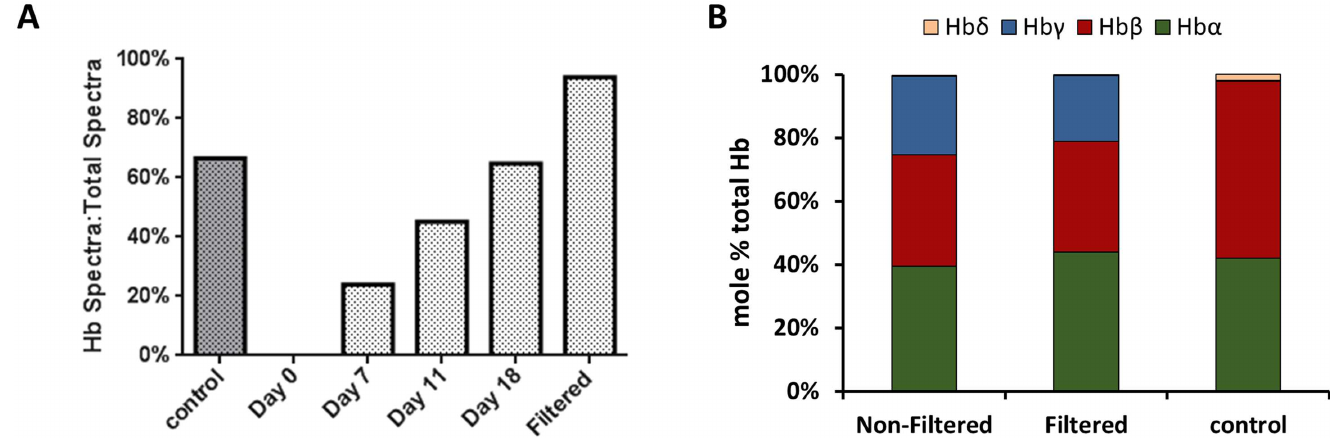
Fig 2. Proteomic analysis of hemoglobin expression. (A) Ratio of spectra (%) matched specificallyto Hb tryptic peptides (spectral count) over total matched spectra duringerythropoietic differentiationof cord blood-derived CD34 + cells along with human control RBCs and filtered cells on day 18. (B) Intensity basedabsolutequantification (iBAQ) was used to calculatethe mole % ratio of peptidesuniqueto α , β and γ Hb subunitsover all identified peptides of filtered (F) and non-filtered(NF) cells on day 18 of culture along with humancontrol RBCs. Other Hb subunitswere found but were < 0.5% of total Hb and are thus not shown on the graph. Standard deviations for α , β , γ , and δ are as follows: (NF): 3.4%, 2.8%, 3.0%, and 0.05%; (F): 4.2%, 9.7%, 5.8, and 0.23%; (control) 6.8%, 7.0%, 0.05%, and 0.36%, respectively.